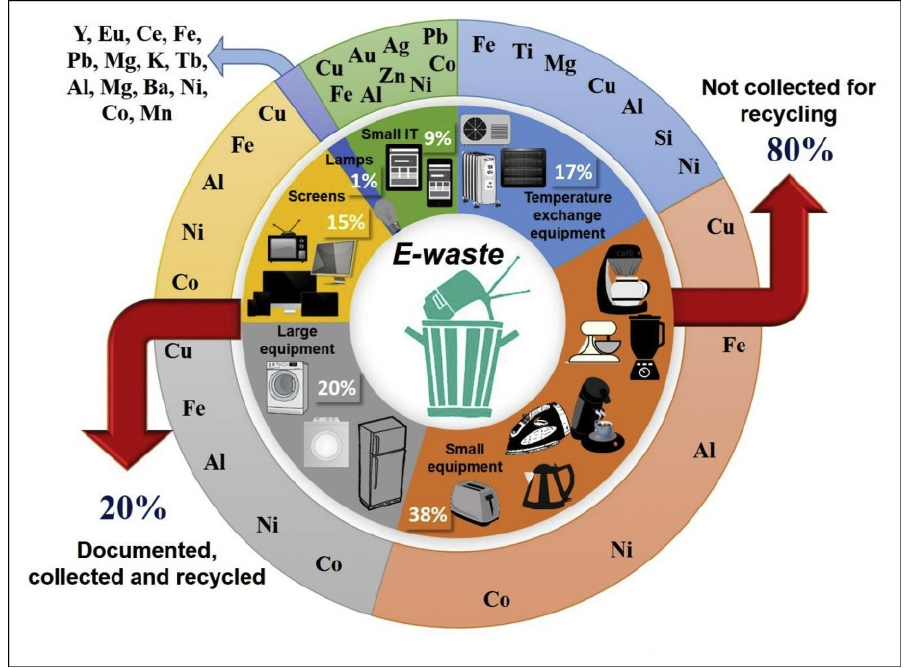
Figure 2. The schematic presentation of e-waste varieties and classification, the current management band, and their elemental compositions [6].